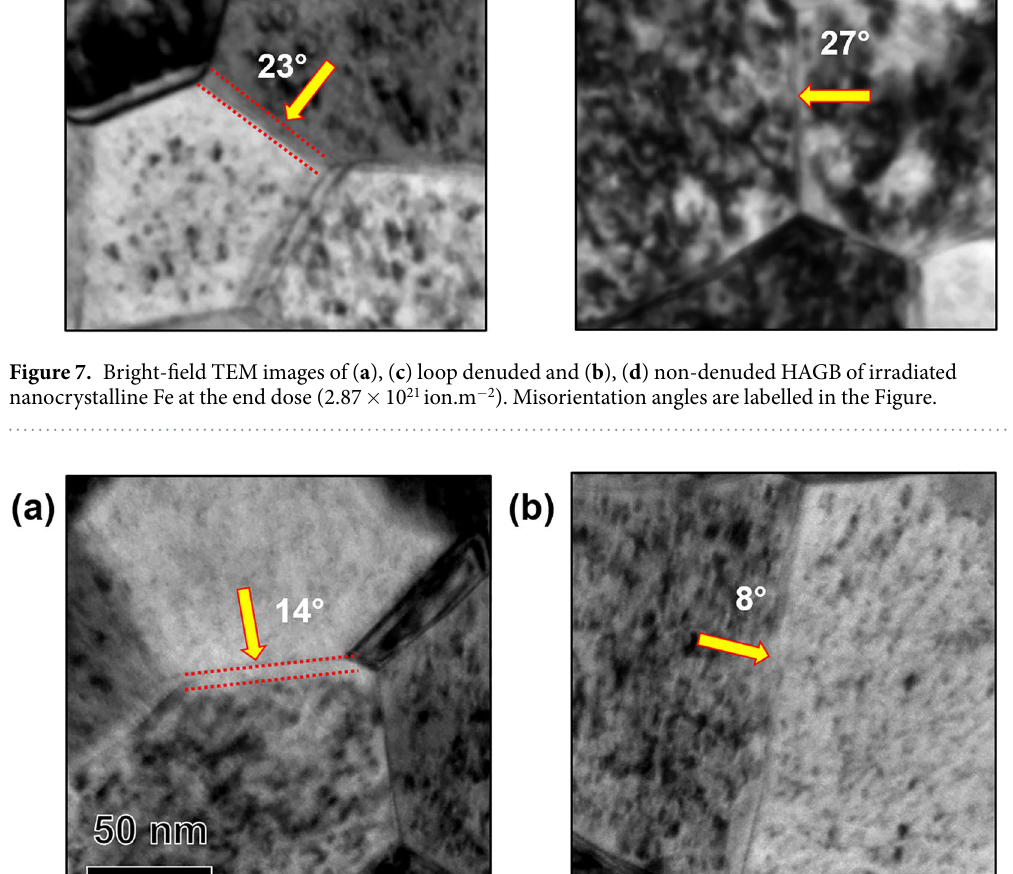
compared to other grains. This suggests a decrease in the first term in equation [1] due to strong interstitial absorption by grain boundaries. On the other extreme, focusing on grain V (ultrafine grain with approximately 270 nm grain diameter), the loop density showed a significant decrease, while the loop area demonstrated significant increase. The decrease in